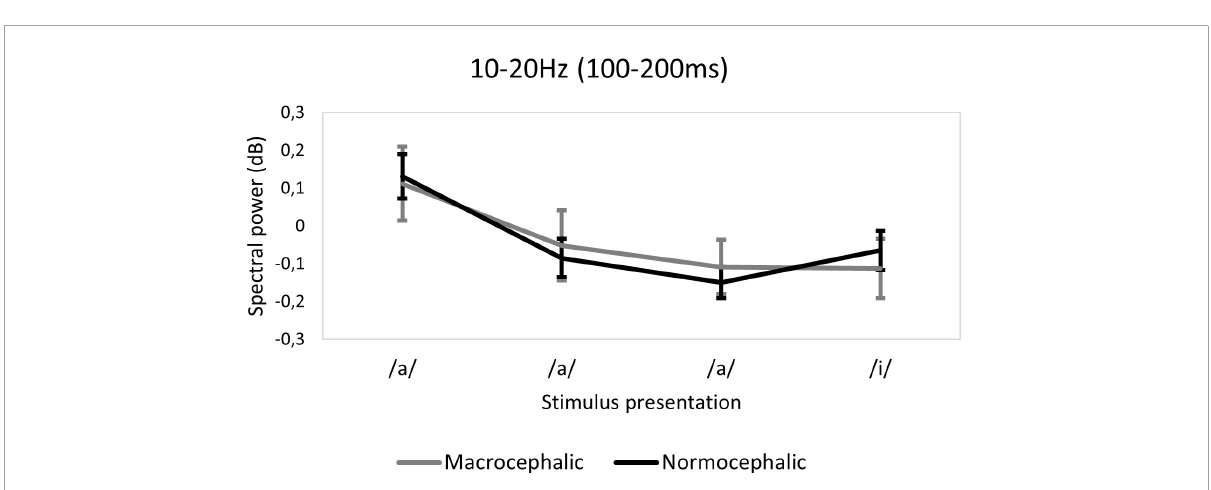
FIGURE4 Ten to twenty Hertz time-frequency window (TFW). Spectral power. Plot demonstrating the pattern of response across presentations of the standard sequence by group. Error bars indicate 95% confidence intervals. dB, decibels.